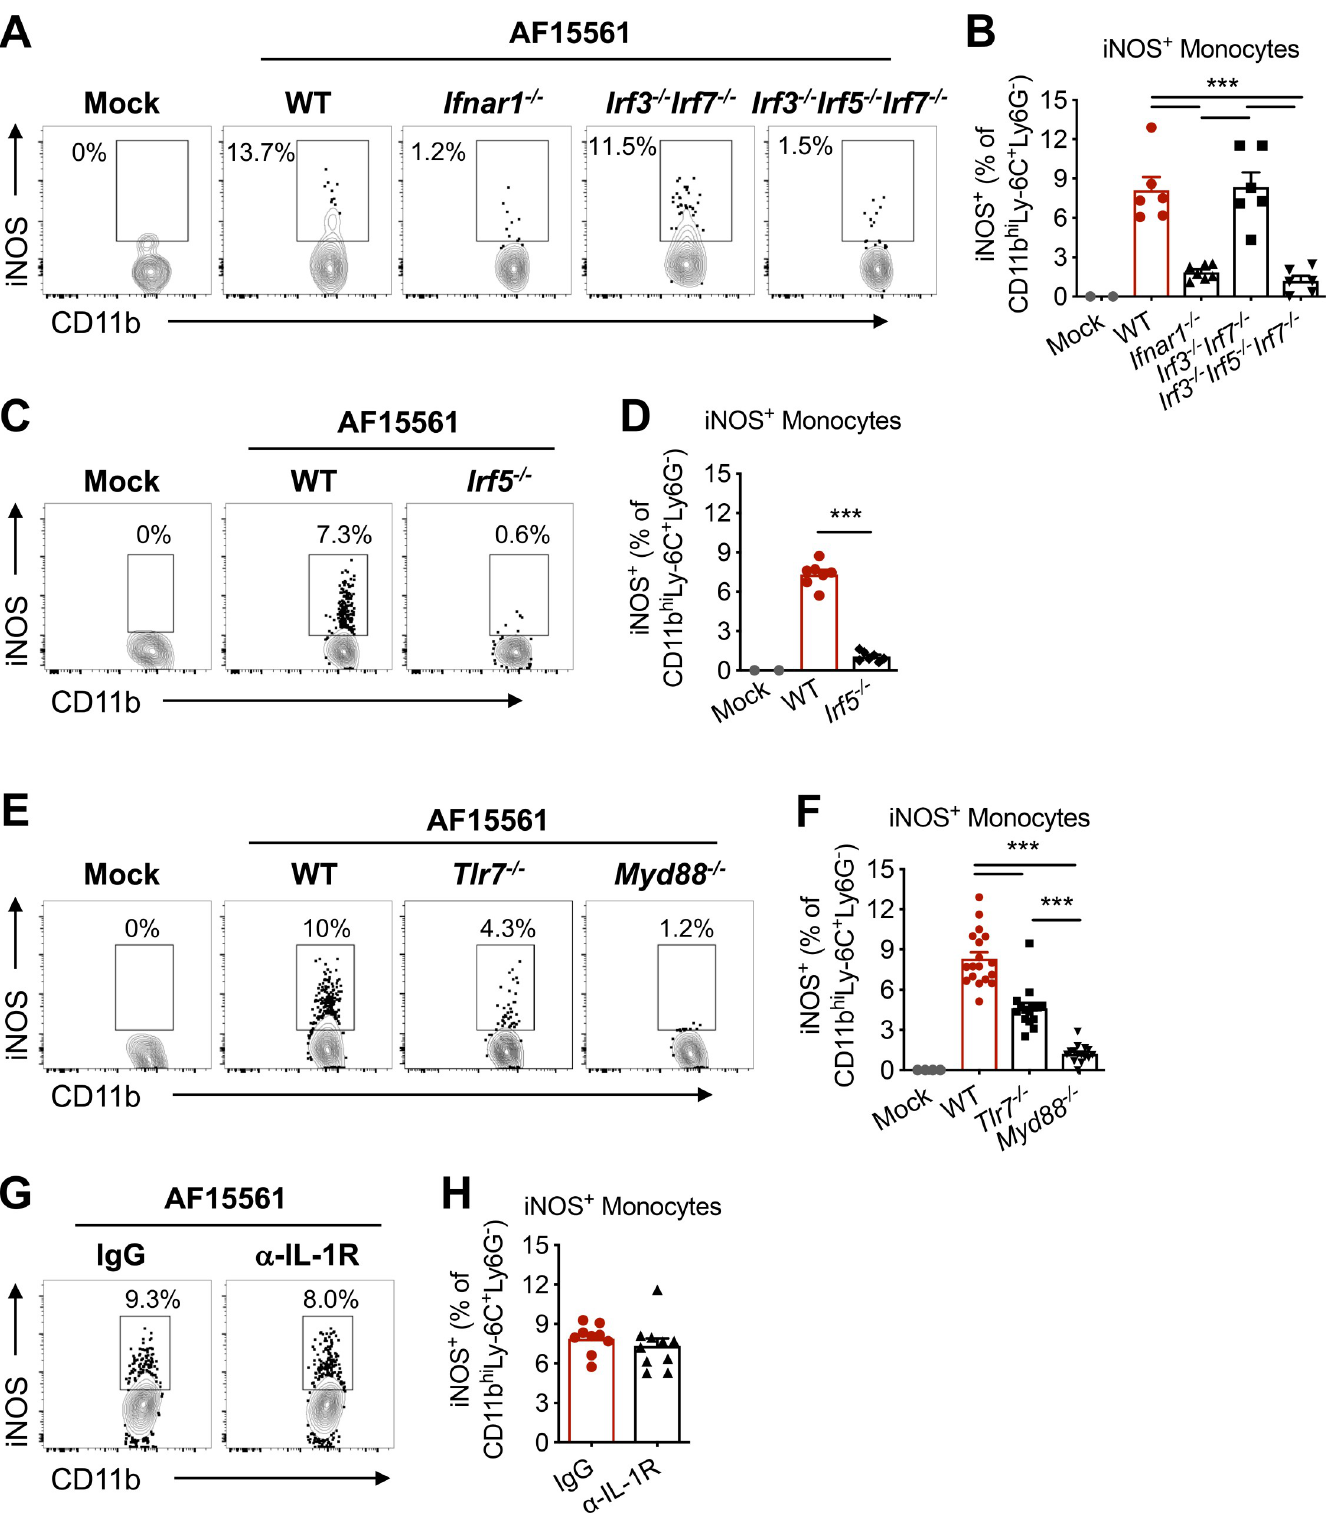
Fig 7. Mechanisms of iNOS expression in monocytes recruited to the dLN. Mice were inoculated with PBS (mock) or 10 3 PFU of CHIKV AF15561 in the left footpad, and the dLN was analyzed at 24 hpi. ( A ) Representative flow cytometry plots and ( B ) percentage of CD11b + Ly6C hi monocytes expressing iNOS in WT, Ifnar1 -/- , Irf3 -/- Irf7 -/- , or Irf3 -/- Irf5 -/- Irf7 -/- mice. ( C ) Representative flow cytometry plots and ( D ) percentage of CD11b + Ly6C hi monocytes expressing iNOS in WT or